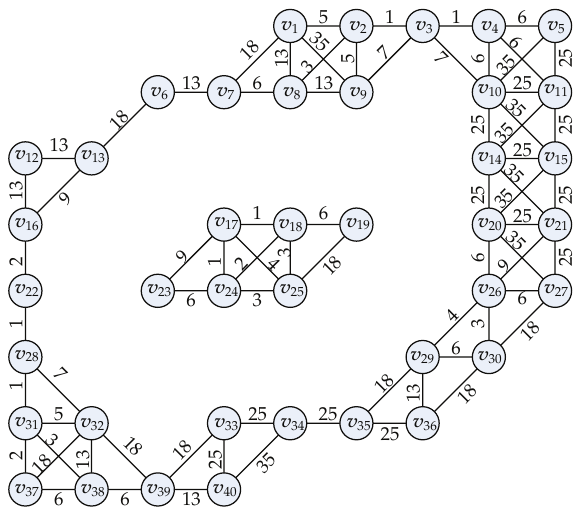
Figure 11: The constructed graph with weights on